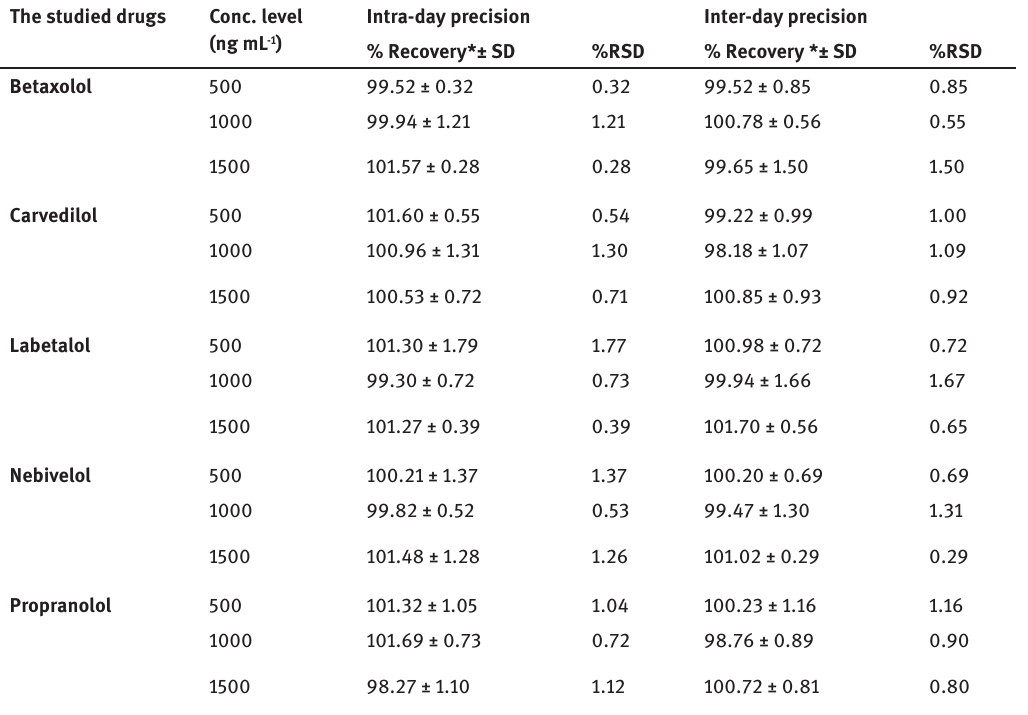
Table 3: Inter-day and Intra-day precision for the determination of the studied drugs by the proposed spectrofluorimetric method. The studied drugs